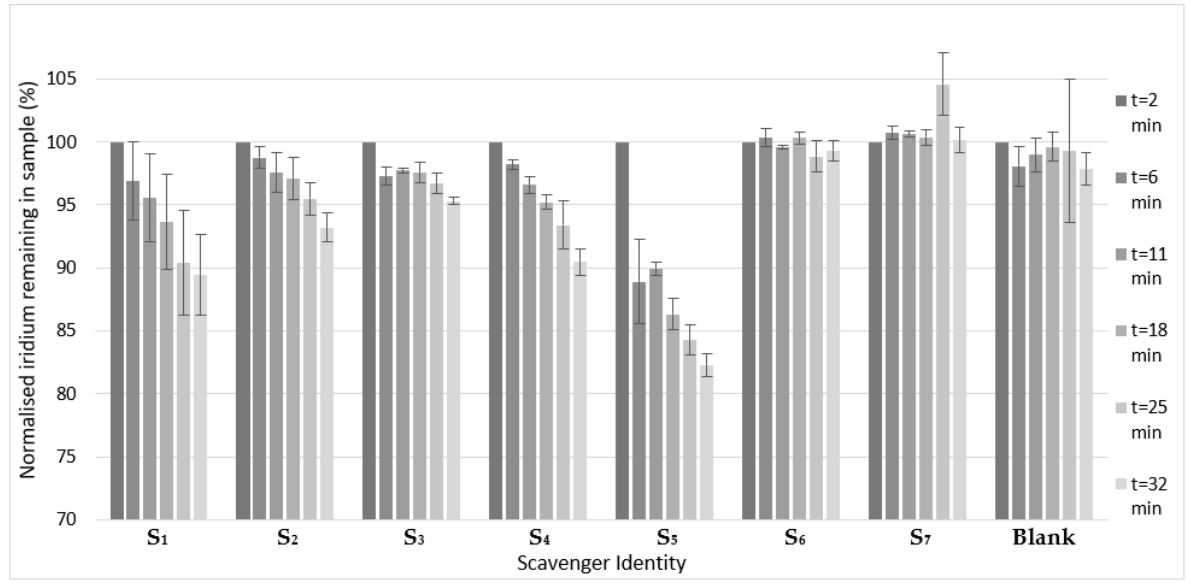
Figure 3. Iridium present in samples following the addition of 10 mg of scavengers S 1 – S 7 and with no scavenger added ( Blank ). Aliquots were taken over a range of time points with t = 2 min being the fastest experimentally feasible sampling time. Errors are one standard deviation between repeat samples ( N = 3). For ease of comparison, the ordinate has been focused towards the top end of the scale.